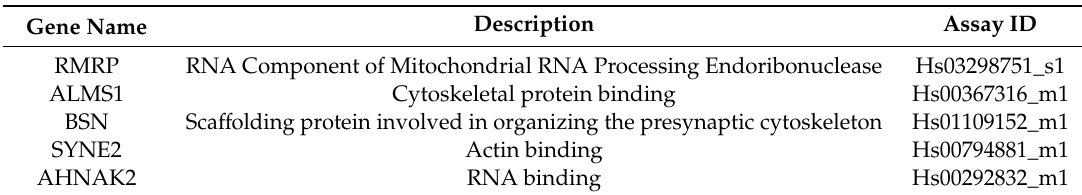
Table 5. Candidate transcripts selected for the validation by qRT-PCR. Inventoried primer probe designs were